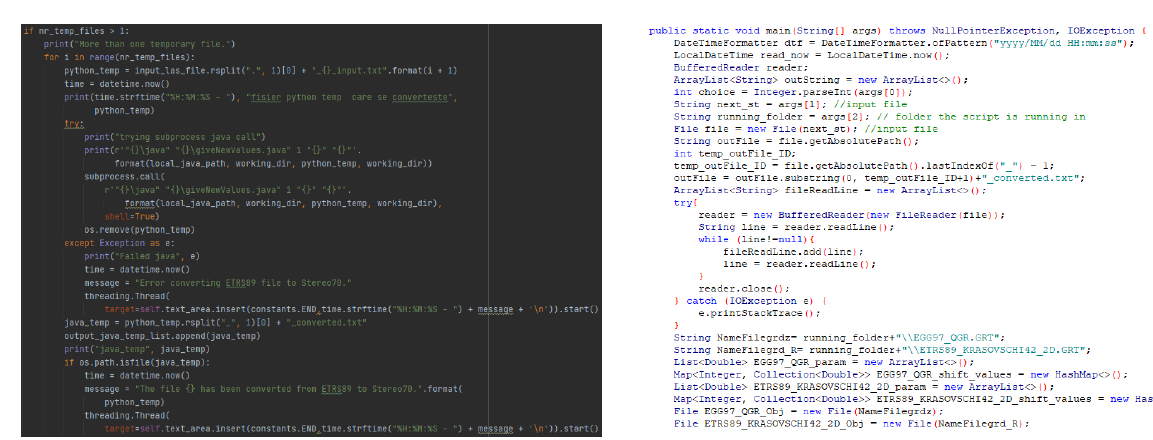
Figure 5 . Part of the changed Java code, adapted for application